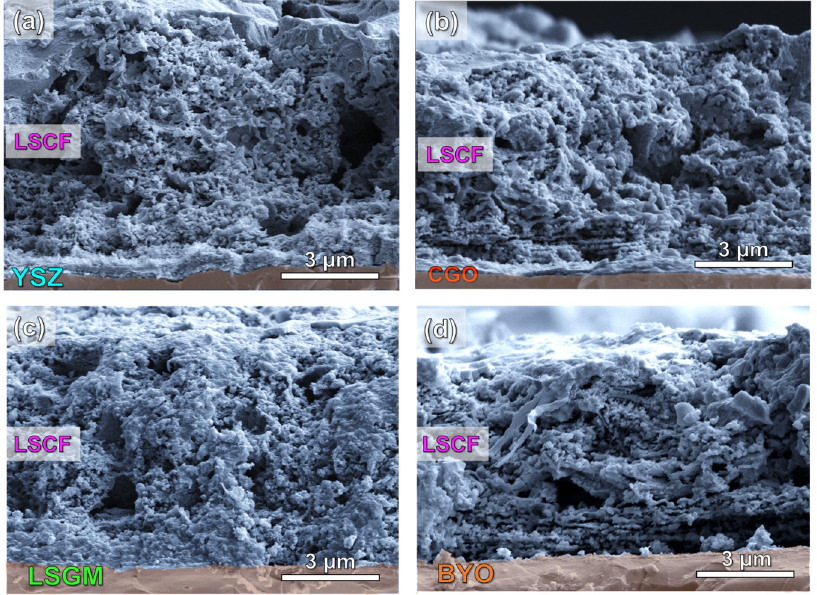
Figure 2. SEM images of the LSCF deposited on different electrolytes at 700 °C, ( a ) YSZ, ( b ) CGO, ( c ) LSGM and ( d ) BYO. ( c ) LSGM and ( d )